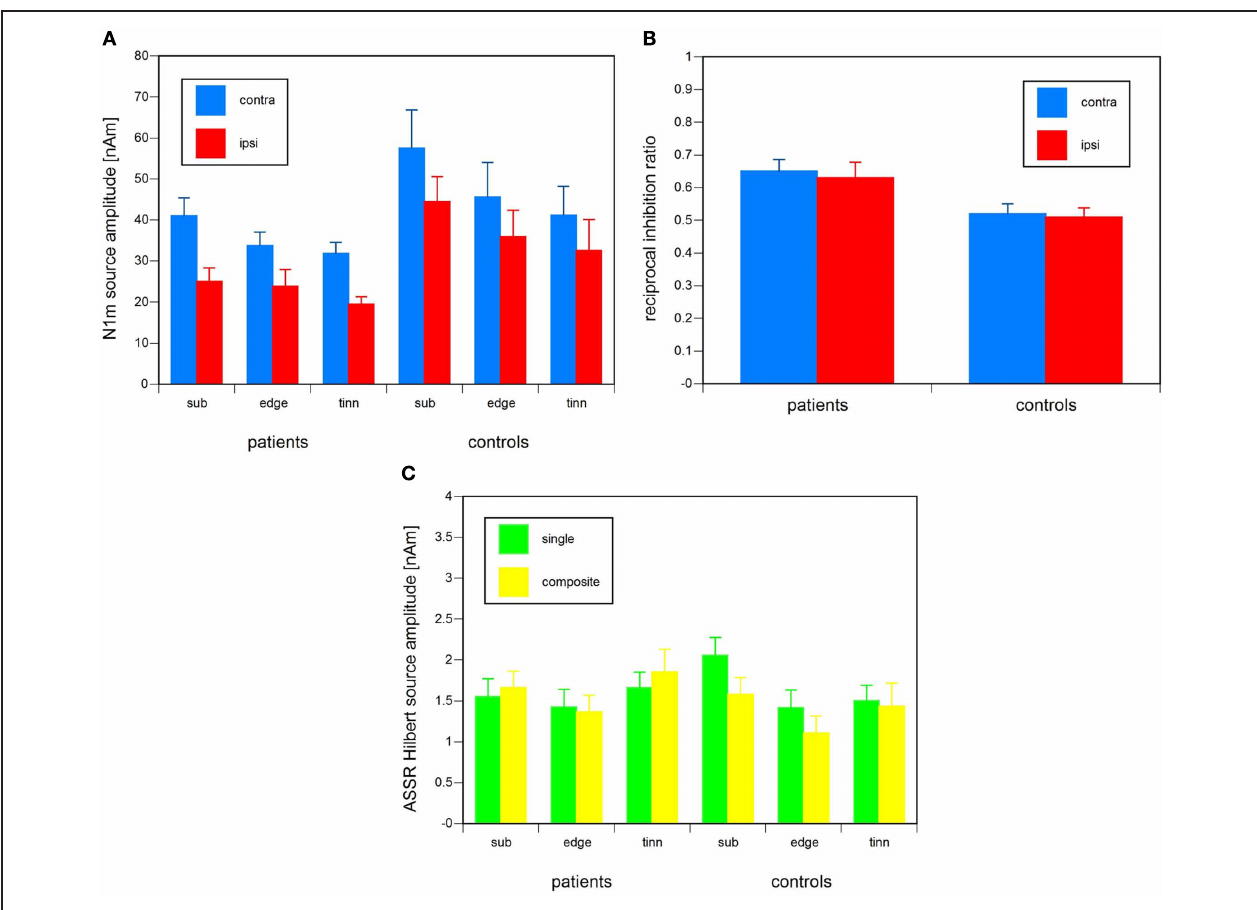
in the three single stimulus conditions, in the contra- and the ipsilateral hemisphere, relative to the stimulated ear, of tinnitus patients, and healthy controls. The error bars represent the standard error of measurement. (C) Sub-edge, edge, and (surrogate) tinnitus single and composite stimulus condition ASSR source amplitude in tinnitus patients and healthy controls [as reported in Diesch et al. (2010a)]. The error bars represent the standard error of